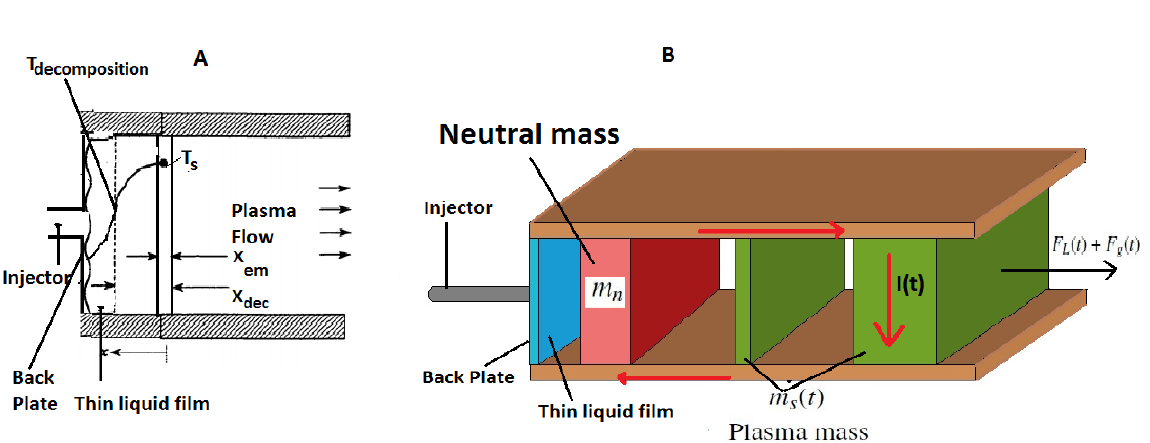
Figure 2. Plasma and neutral mass: ( A ) Emission; ( B ) Flow for liquid-fed